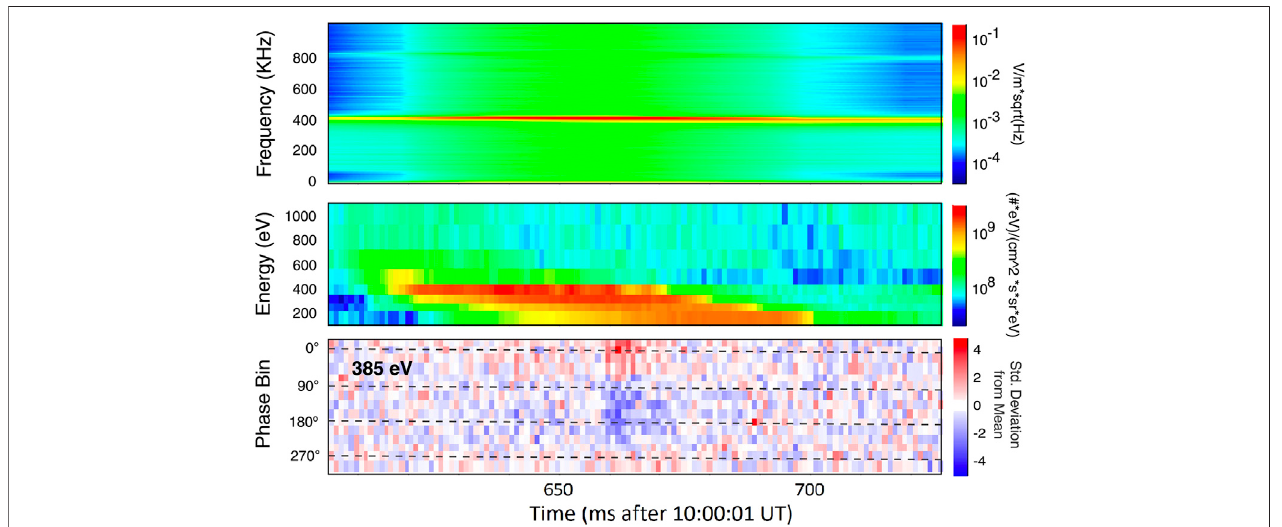
FIGURE 6 | Adapted from Kletzing et al. (2017): Langmuir wave electric fi eld, particle, and wave-particle correlator data measured near 725 km altitude with the CHARM-2soundingrocket. Toppanel: electric fi eld spectrogram showing extremelymonochromaticLangmuirwavesslightlyabove 400 kHz.Middlepanel: energy fl ux spectrogram of downgoing electrons showing broadband dispersed feature below 500 eV coincident with the Langmuir waves. Bottom panel: the output of the wave- particle correlator showing signi fi cant bunching of 385 eV downgoing electrons in the fi eld of the wave at 10:00:01.66 UT, evidenced by count rates signi fi cantly above or below expected values in most of the sixteen phase